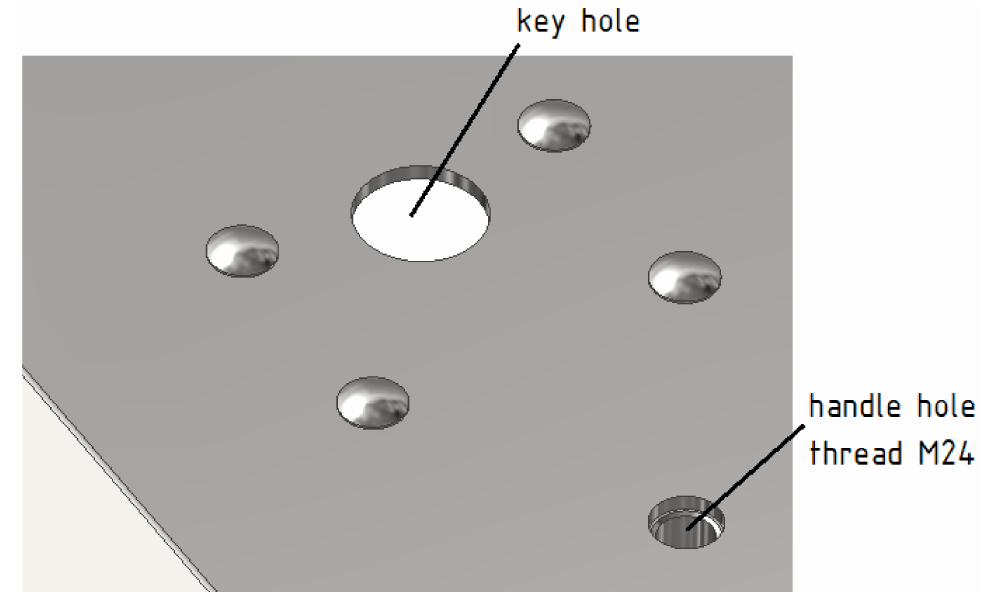
Figure 9. View of the hole used to unlock the lock and the thread used for the special